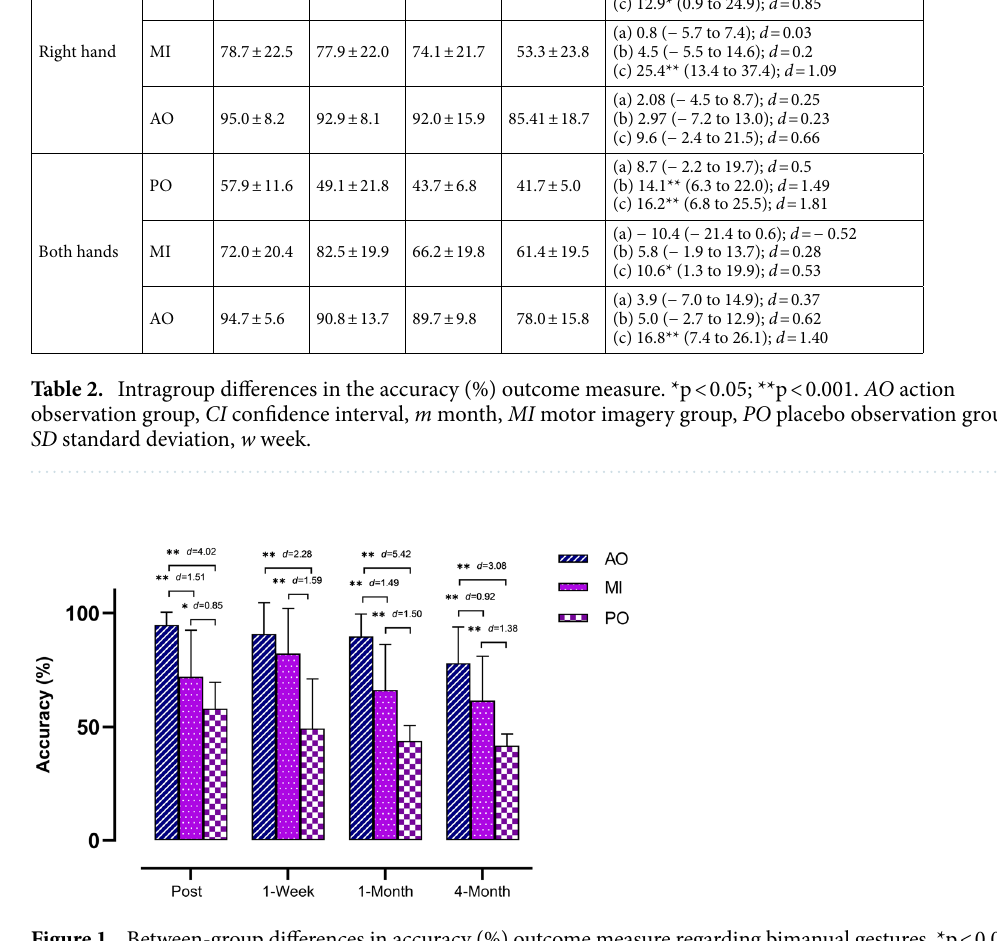
Figure 1. Between-group differences in accuracy (%) outcome measure regarding bimanual gestures. *p < 0.05; ** p < 0.001; AO action observation, MI motor imagery, PO placebo observation group, d d of